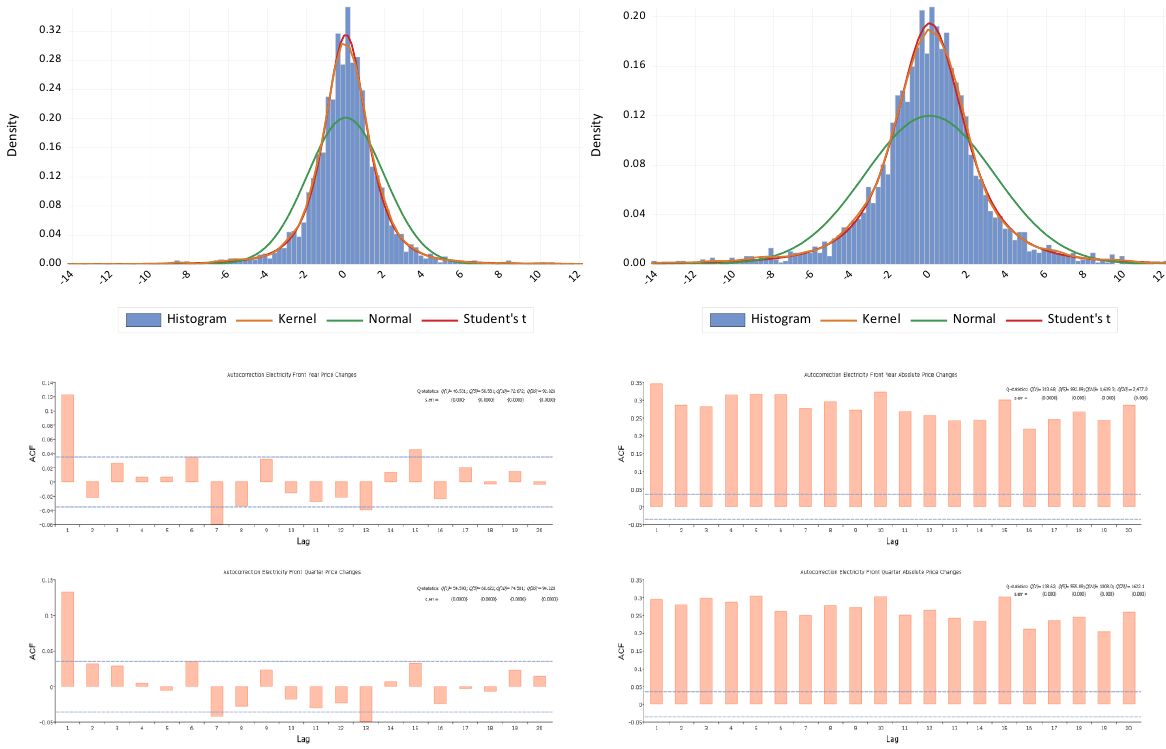
Figure 1. Nasdaq OMX Front Year and Front Quarter Contracts for the period 2010 – 2022.